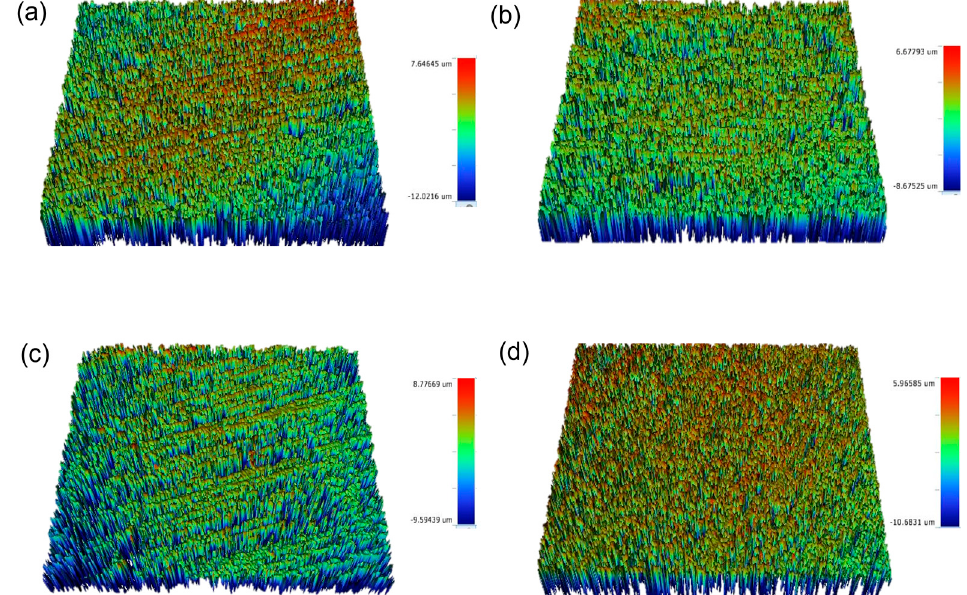
Figure 5. Surface roughness (Ra) of manual metal scaling of each: ( a ) CD, ( b ) CT, ( c ) IPE, and ( d ) IPS. CD; zirconia-reinforced lithium silicate (Celtra Duo). CT; advanced lithium disilicate (CEREC Tessera). IPE; lithium disilicate (IPS Emax CAD). IPS; leucite-reinforced (IPS Empress CAD).